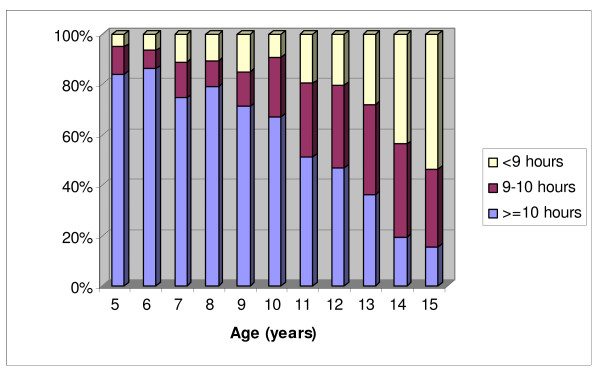
Distribution of sleep duration among children aged 5-15 years in South Australia